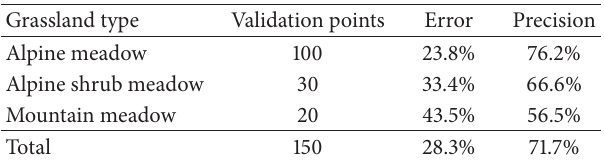
Table 2: Validation